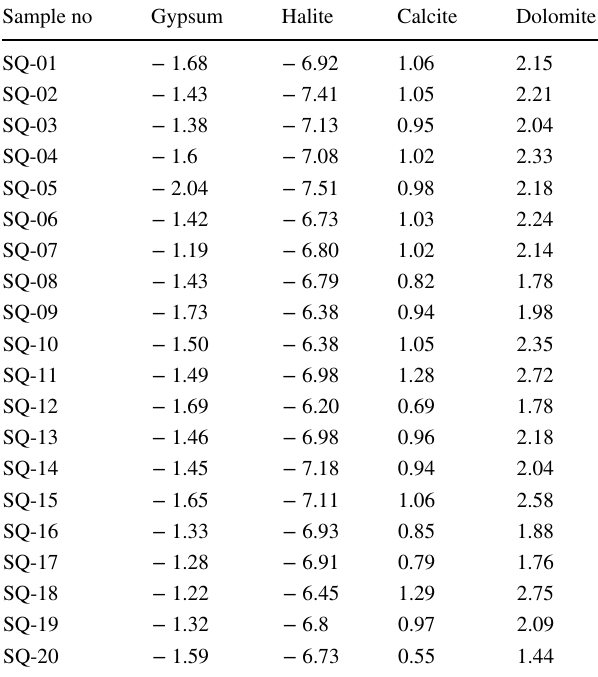
Table 3 Calculation for mineral saturation index Sample no Gypsum